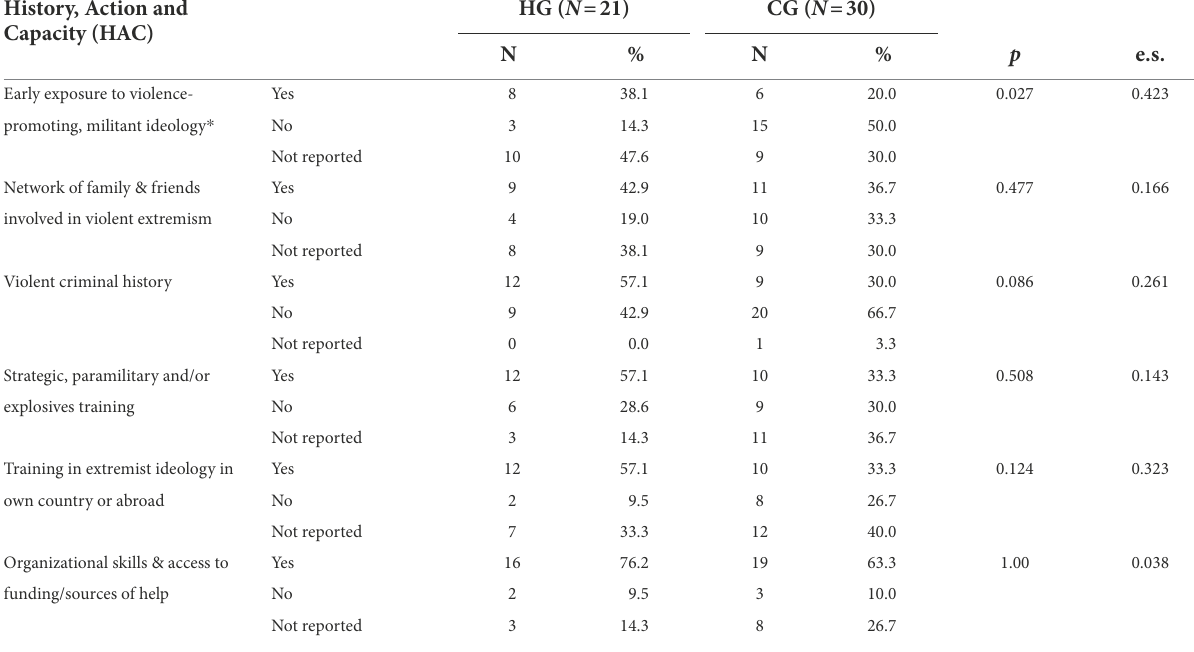
TABLE 5 History, action, and capacity in male Jihadist homicide offenders (HG) and male Jihadist non-homicide offenders (CG). History, Action and Capacity